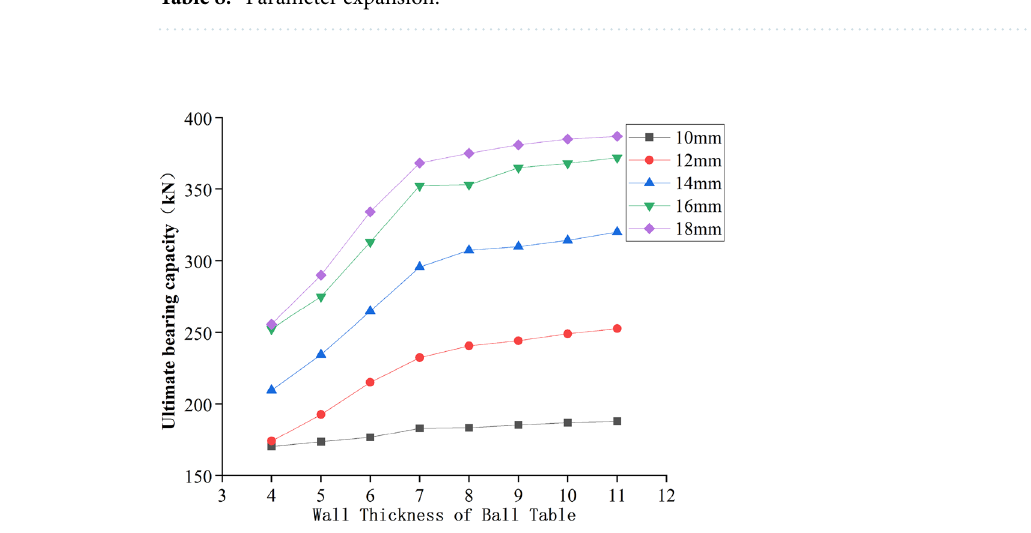
Table 8. Parameter expansion.